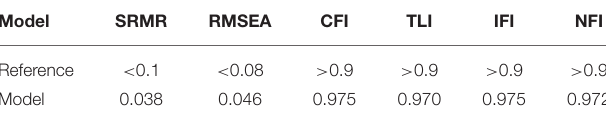
TABLE 4 | The fit of the structural equation